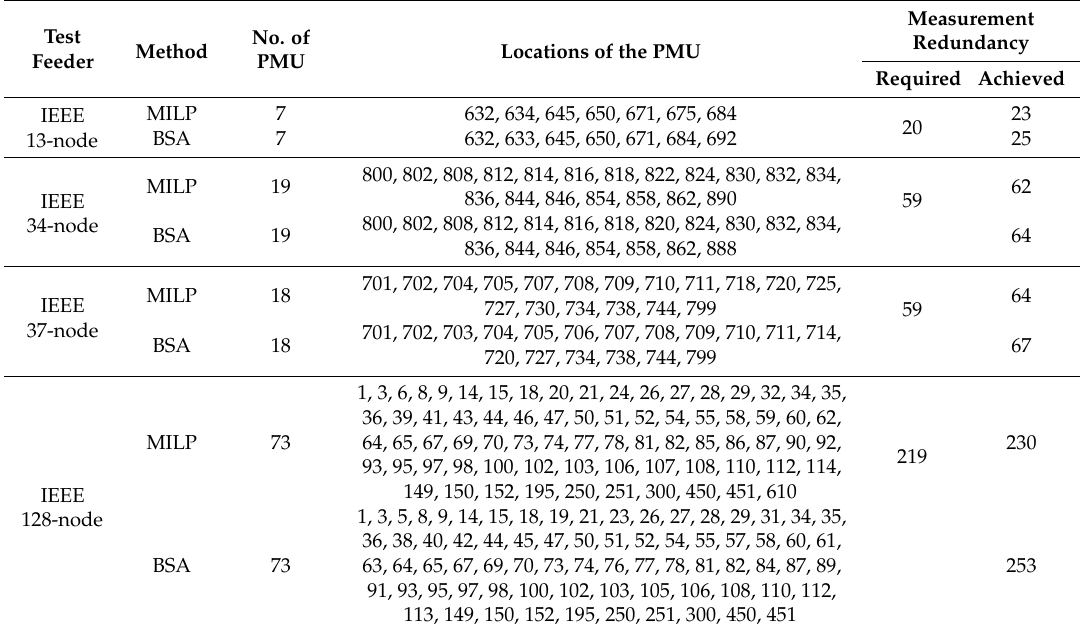
Table 4. Optimal numbers and locations of PMU without considering ZIB and channel limits during single line outage